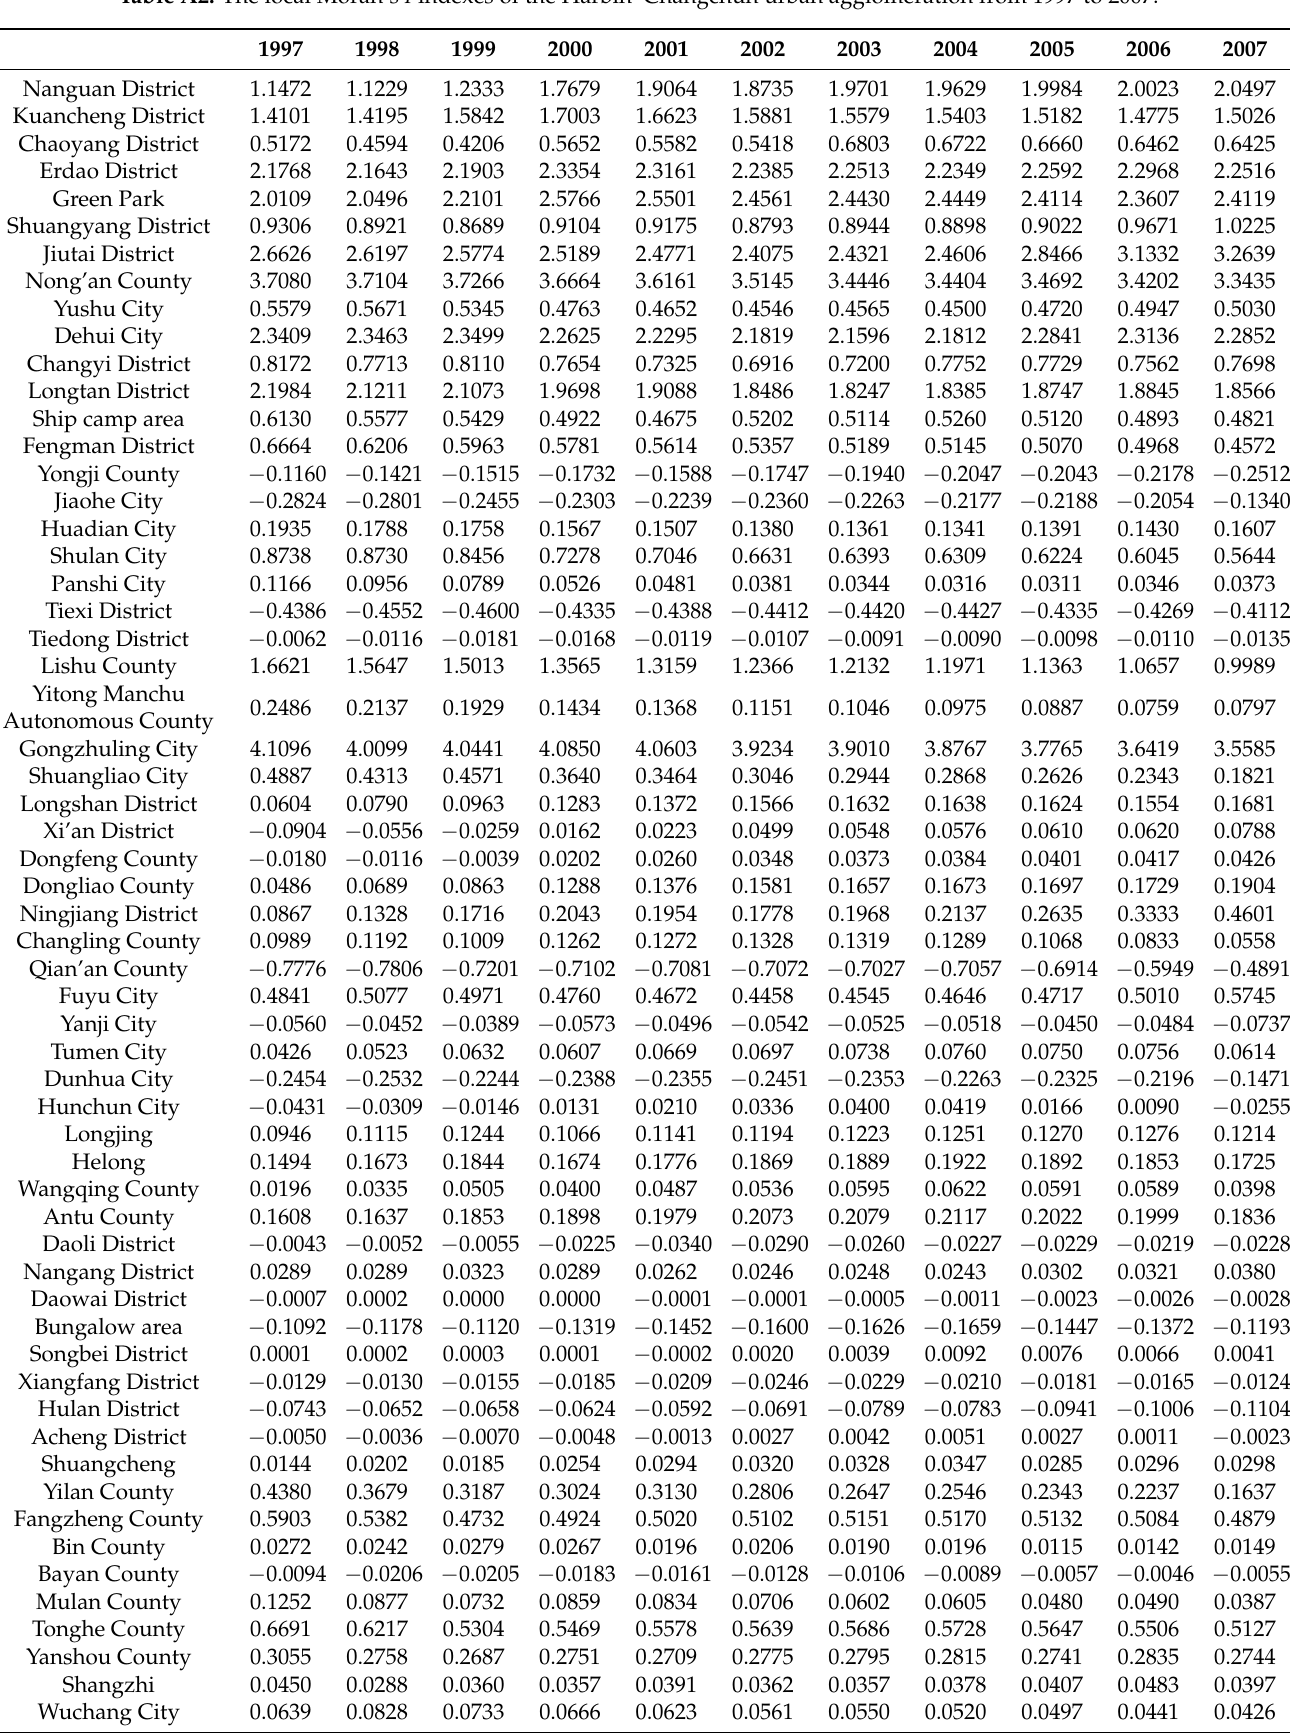
Table A2. The local Moran’s I indexes of the Harbin–Changchun urban agglomeration from 1997 to